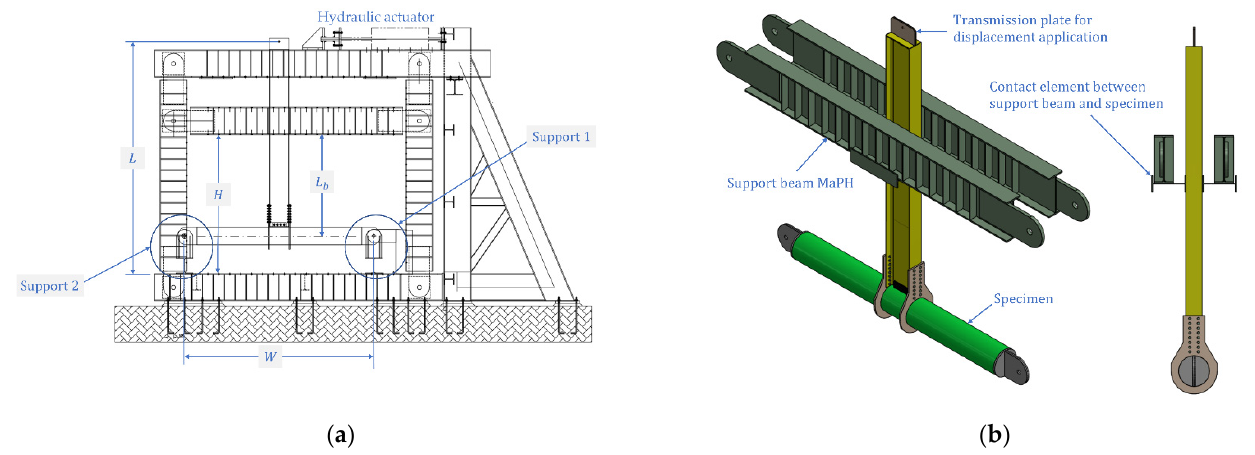
Figure 2. Experimental setup: ( a ) mounting details of the beam-column connection; and ( b ) beams that provide lateral support to the framework [19].